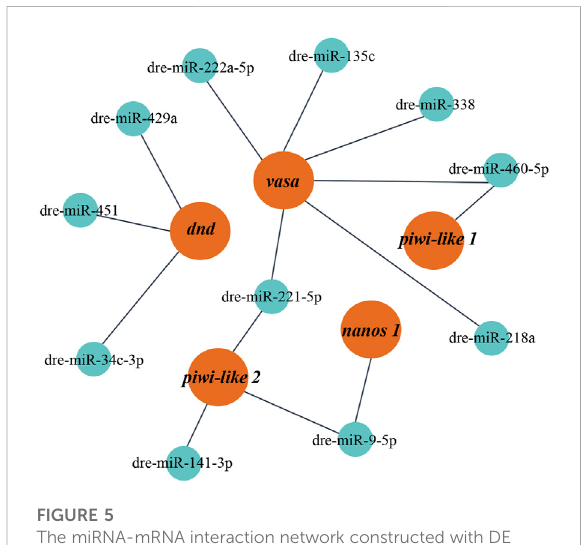
FIGURE 5 The miRNA-mRNA interaction network constructed with DE miRNAs. Red represents target mRNAs and green represents